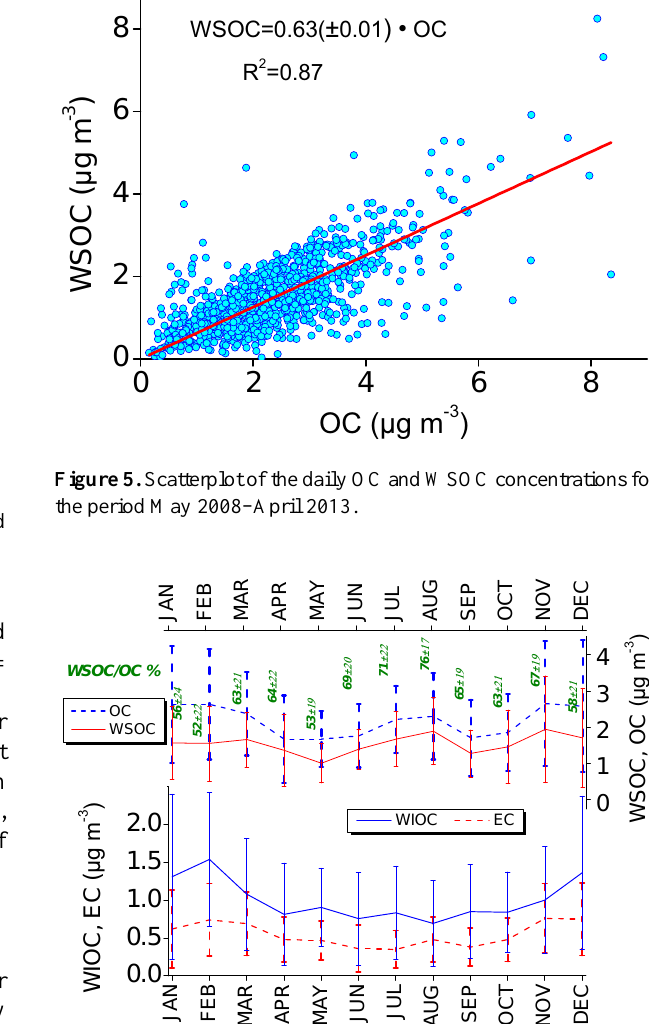
Figure 6. Average seasonal cycle of OC, EC, WSOC, WIOC con- centrations and the WSOC / OC ratio calculated from daily values for the period May 2008–April